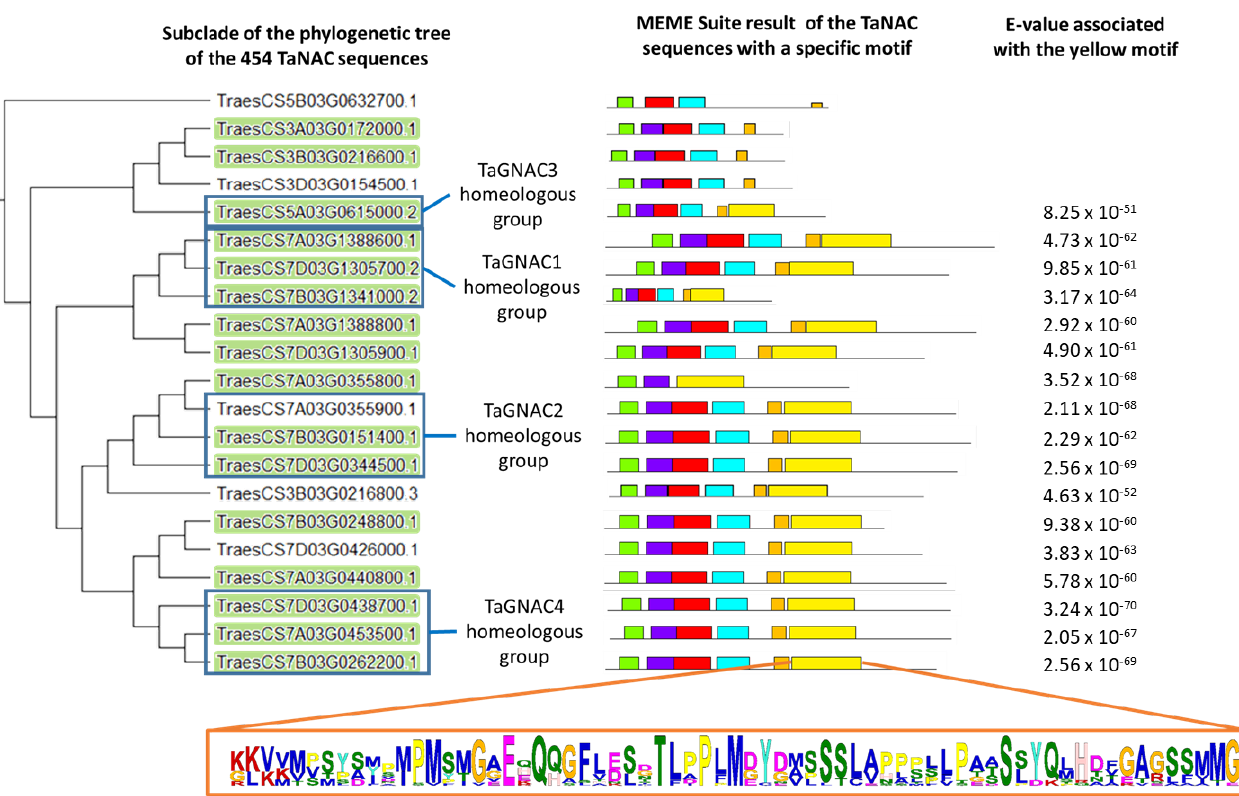
Figure 3. Clade extracted from the phylogenetic tree carrying the 454 high confidence sequences of the TaNAC family of bread wheat, identified in the new RefSeq v2.1 database. The homeologous sequences of the TaGNAC1 , TaGNAC2 , TaGNAC3 and TaGNAC4 genes existing in this database are framed in blue. Of the 19 sequences expressed preferentially in the grain, 16 are carried by this clade (highlighted in green). Within this clade, 17 sequences carry a specific conserved pattern (yellow block), presented in Logo format at the bottom of the figure.